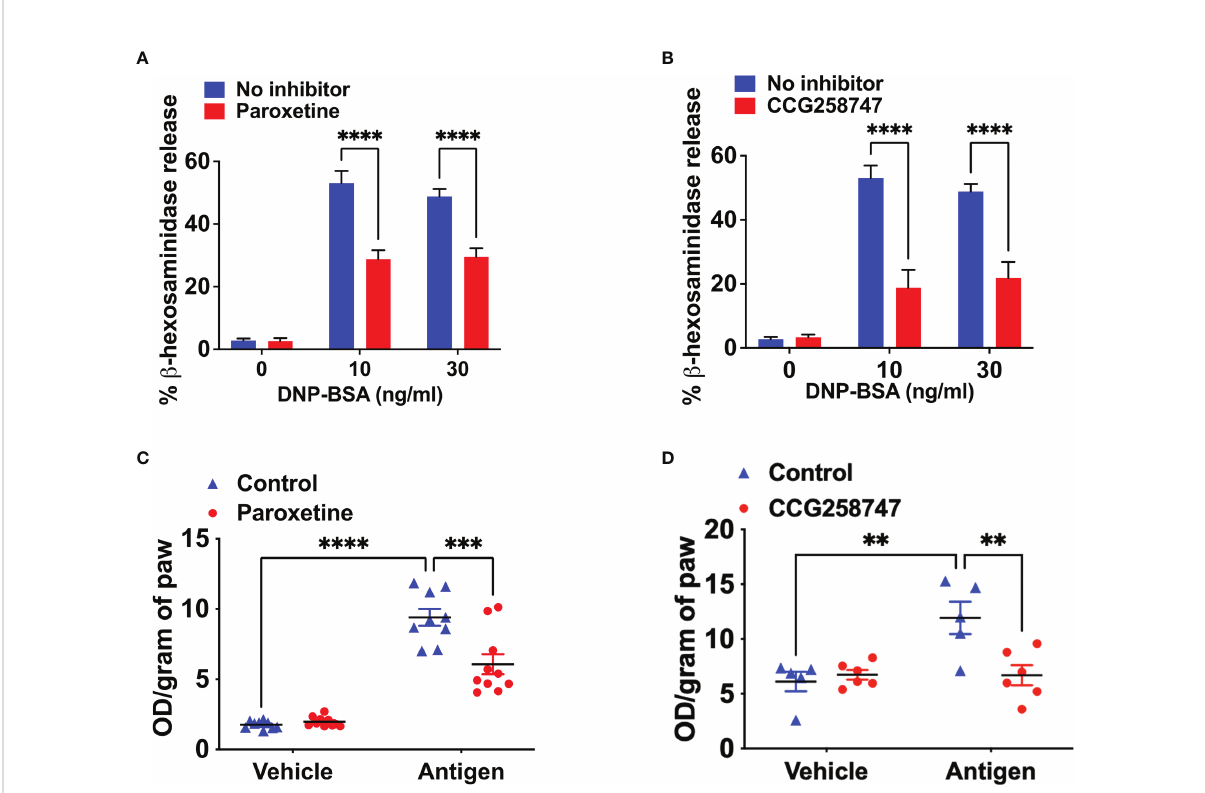
FIGURE 2 Paroxetine and CCG258747 inhibit IgE-mediated degranulation in primary LMCs in vitro and cutaneous anaphylaxis in vivo . Measurement of b - hexosaminidase release in IgE-primed LMCs pre-incubated with (A) paroxetine (30 µM) and (B) CCG258747 (30 µM) and challenged with antigen (30 ng/mL). C57BL/6 mice (n=8-10) were sensitized with IgE (20 ng, 30 µL, right hind paw) and vehicle (PBS, 30 µL, left hind paw) for 24 hrs and were intravenously injected with paroxetine or CCG258747 (5 mg/kg, 100 µL, 30 min) or respective vehicle (100 µL, 30 min) following antigen (20 µg, 200 µL in 1% Evans blue dye in PBS, 30 min) challenge or vehicle (PBS) intravenously. Evans blue dye extravasation was determined. Quanti fi cation of vascular permeability for (C) paroxetine (D) CCG258747. Error bars are standard error of mean (SEM)